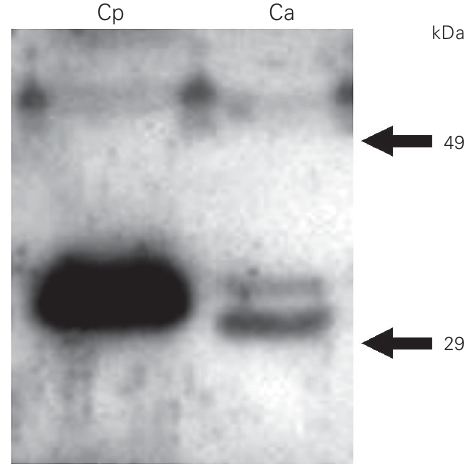
Figure 2. Immunodetection